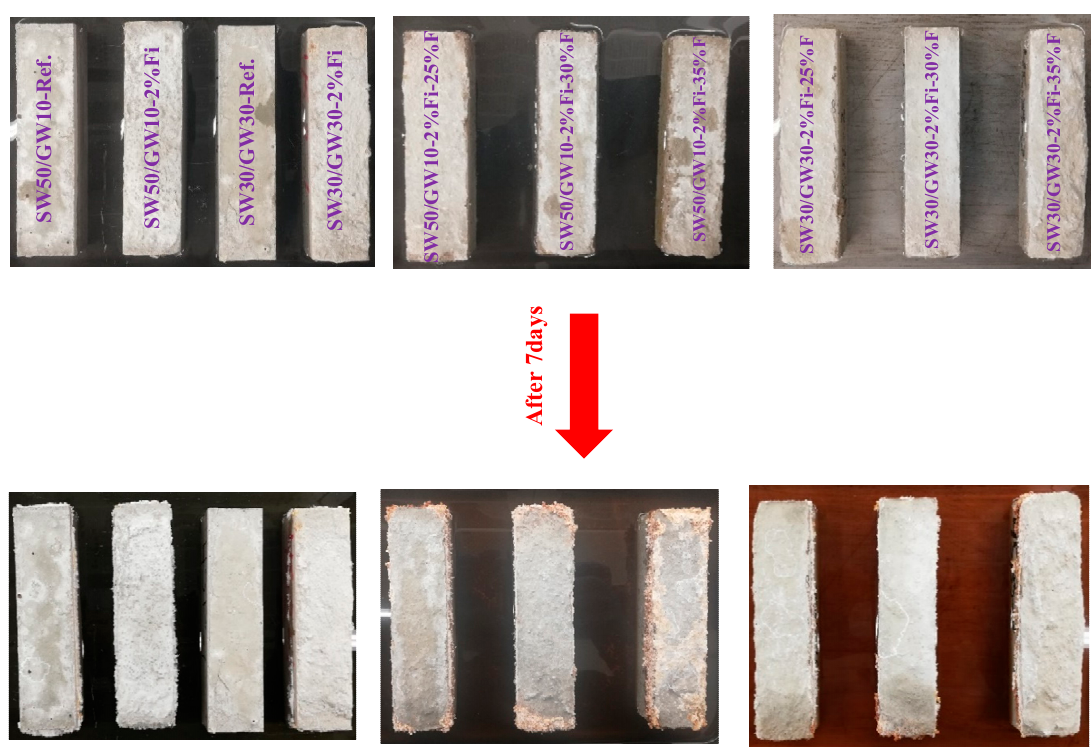
Figure 10. Visual observations of the efflorescence. (Ref., Fi, and F were used in place of Reference, Fiber, and Foam, respectively.).